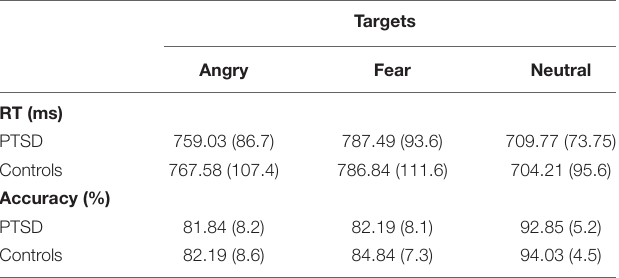
TABLE 2 | Mean reaction times and percent accuracy are shown for PTSD patients and military controls.